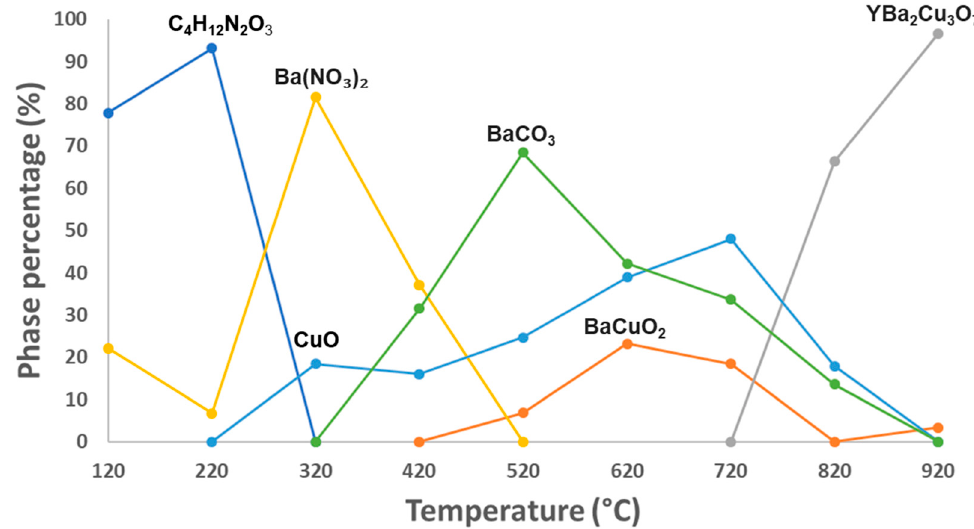
Figure 5. Graphical representation via qualitative analysis of pXRD patterns from the temperature analysis of the synthesis of YBCO (123) superconductor in the 5:1 molar ratio of tetramethyl ammonium nitrate/metal nitrates.